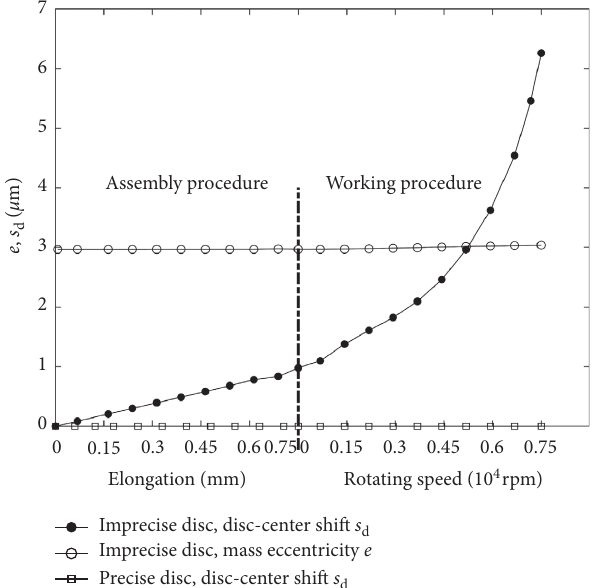
Figure 7: Axis-center shift and mass eccentricity and of disc “b” with the position error of bolt-holes.